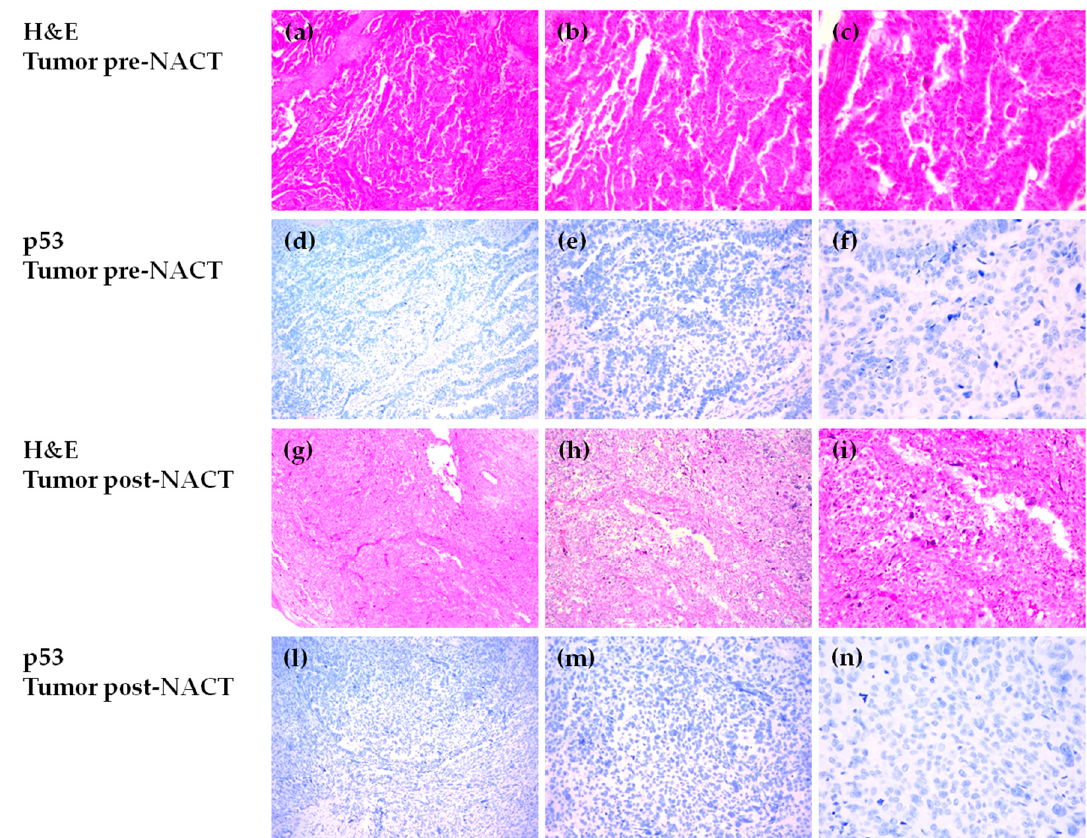
Figure 5. Hematoxilin and eosin (H&E, 5×, 10× and 20× magnification) of HGSOC sections collected at D-LPS (pre-NACT) and at IDS (post-NACT) and immunohistochemical staining for p53 (10×, 20× and 40× magnification). ( a – c ) H&E of bouin-fixed, paraffin-embedded tumor tissue collected at D-LPS showing the serous ovarian carcinoma architecture of HGSOC case with somatic mutation in TP53 ( a : 5×; b : 10×; c : 20×); ( d – f ) Absent (-) nuclear p53 expression on tumor tissue collected at D-LPS of HGSOC case with somatic mutation in TP53 ( d : 10×; e : 20×; f : 40×); ( g – i ) H&E of formalin-fixed, paraffin-embedded tumor tissue collected at IDS showing the serous ovarian carcinoma architecture of HGSOC case with somatic mutation in TP53 ( g : 5×; h : 10×; i : 20×); ( l – n ) Absent (-) nuclear p53 expression on tumor tissue collected at IDS of HGSOC case with somatic mutation in TP53 ( l : 10×; m : 20×; n : 40×). No cytoplasmic staining was observed. NACT: neo-adjuvant chemotherapy; HGSOC: